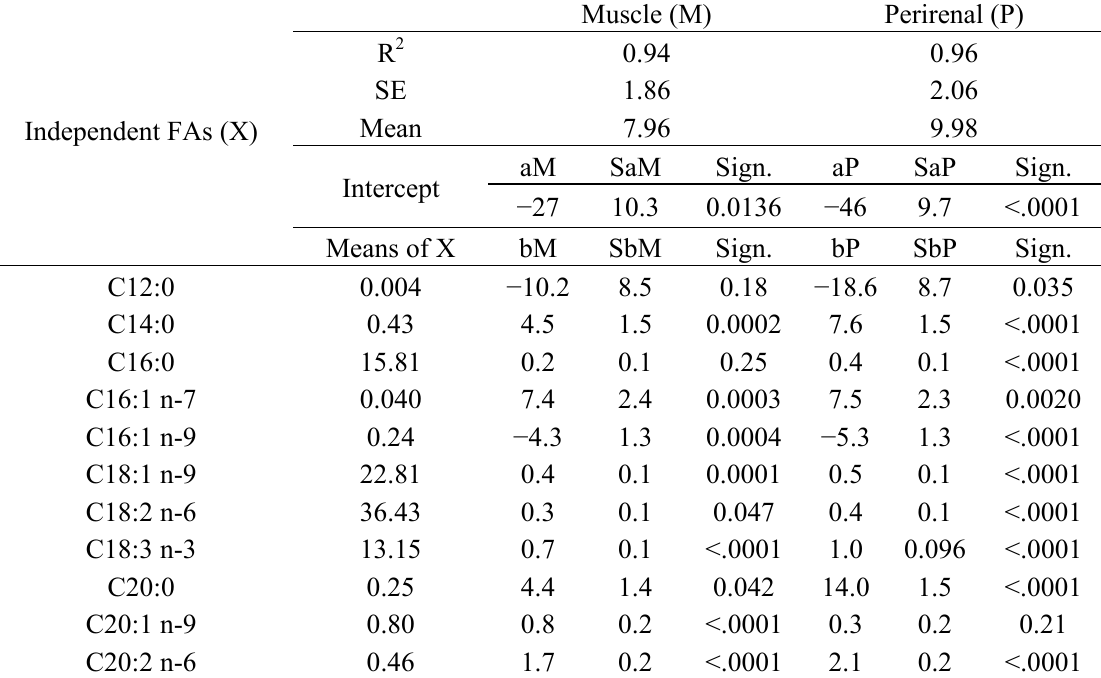
Table 4. Linear regression equations of the total sum of n-3 PUFA (C18:3 n-3 + C20:3 n-3 + C20:5 n-3 + C22:6 n-3) in the longissimus dorsi muscle (M) and in the perirenal fat (P) on percentage of the eleven fatty acids in the